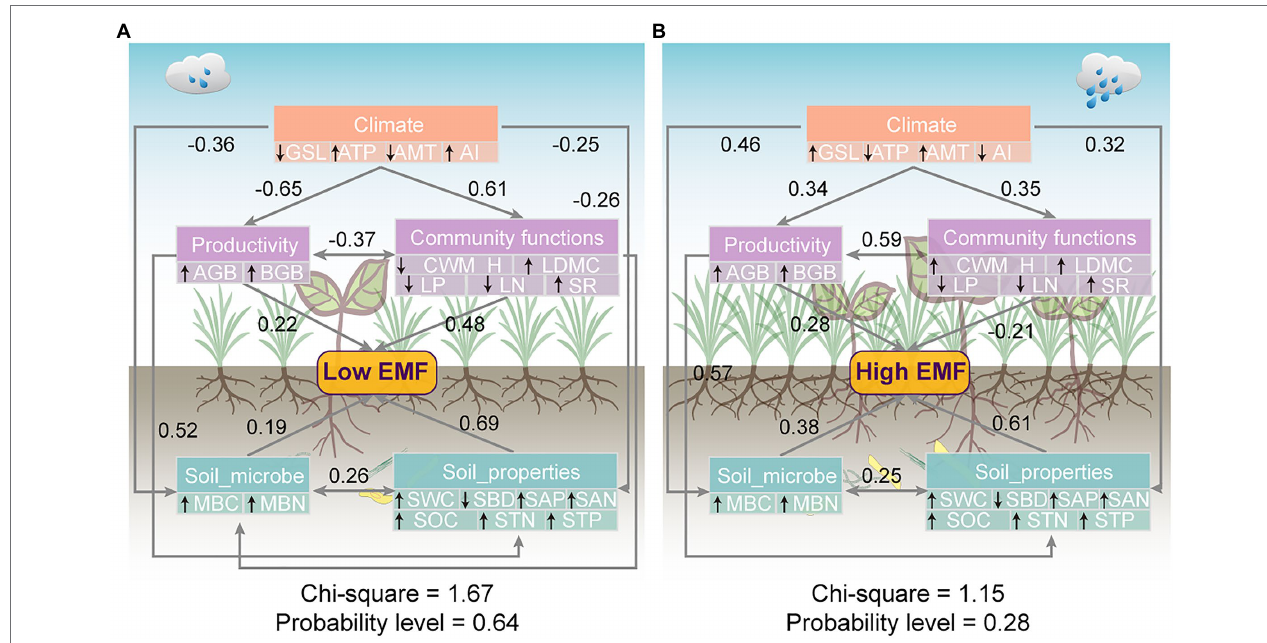
FIGURE 6 | Mechanisms for the patterns of (A) low ecosystem multifunctionality and (B) high ecosystem multifunctionality. Structure equation model examining the standard total effects of climate, productivity, community functions, soil properties, and soil microbial factors on EMF. Given are the standardized total path coefficients. Gray arrows represent significantly paths ( p < 0.05). Black arrows pointing up or down in double-layer rectangles represent the positive or negative relationships between the observed variables and potential